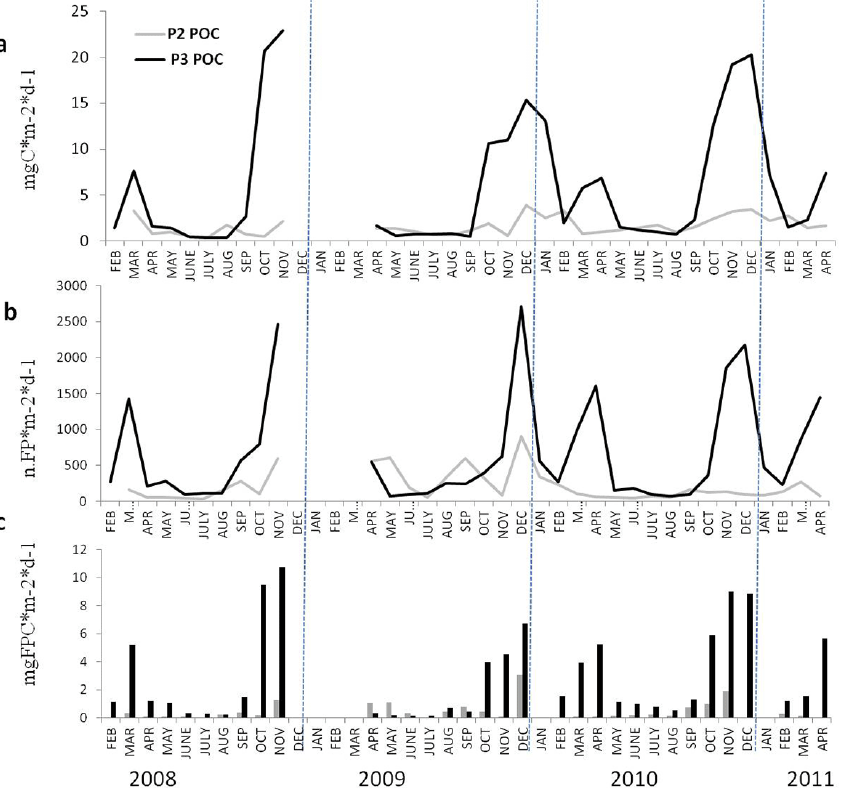
Figure 3. Interannual variability (2008–2011) of (a) POC (mgCm − 2 d − 1 ) , (b) FP (n. FPm − 2 d − 1 ), (c) FPC (mgFPCm − 2 d − 1 ) at P3 (black) and P2 (grey). Table 1. Average FPC ( ± SD, mgCmm − 3 ) of each FP category in spring–early autumn and autumn–winter. Ovoid and ellip. Round